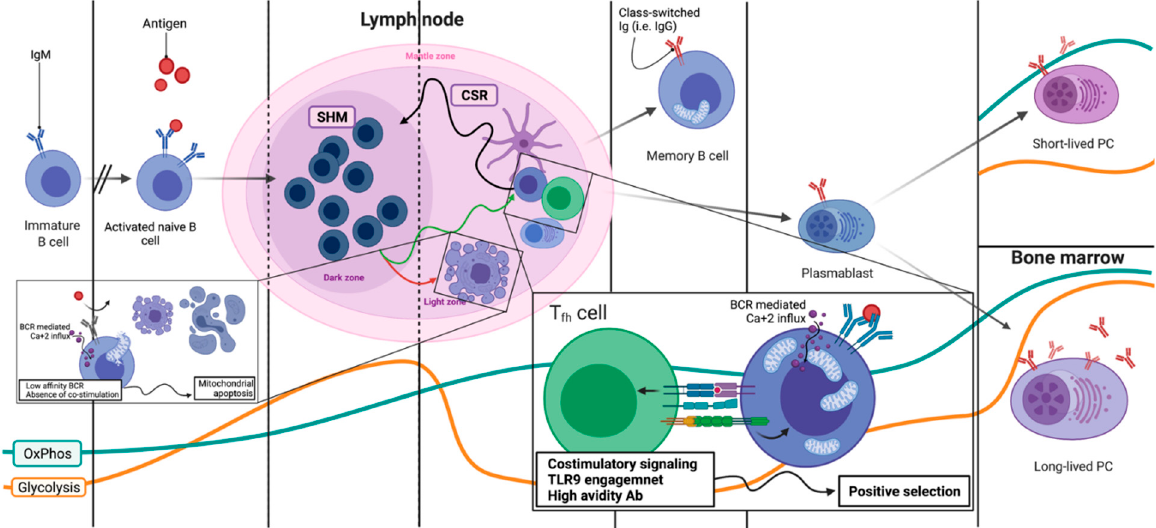
Figure 4. B cell differentiation completion in secondary lymphoid organs. The GC reaction is shown. B cells undergo multiple rounds of SHM in the dark zone (DZ) and then positive selection in the light zone (LZ) until the avidity of their surface BCR is adequate to guarantee them class switching and either the memory B cell or plasma cell fate. Positive (or negative) selection occurs through a mitochondrial-based mechanism that involves Ca +2 influx due to BCR signaling. If the BCR/Ab does not bind with high avidity to the stimulating Ag, or if there are no costimulatory signals (either T cell-derived or TLR9), mitochondria internalize the cytoplasmic Ca +2 and the apoptotic cascade described in Figure 1 is initiated. Co-stimulations or high avidity initiate a rescuing cascade, that involves NF- κΒ activation and antiapoptotic protein expression, that rescues the B cell and allows further entry into the DZ for subsequent modifications. Again, energy modulation and bioenergetic swifts regulate proliferation and genomic editing and are depicted in the lower part of the figure (orange—glycolysis, blue—OxPhos). SHM: somatic hypermutation, CSR: class switch recombination, Tfh: T follicular helper cell, TLR9: Toll-like receptor 9. Created with BioRender.com.